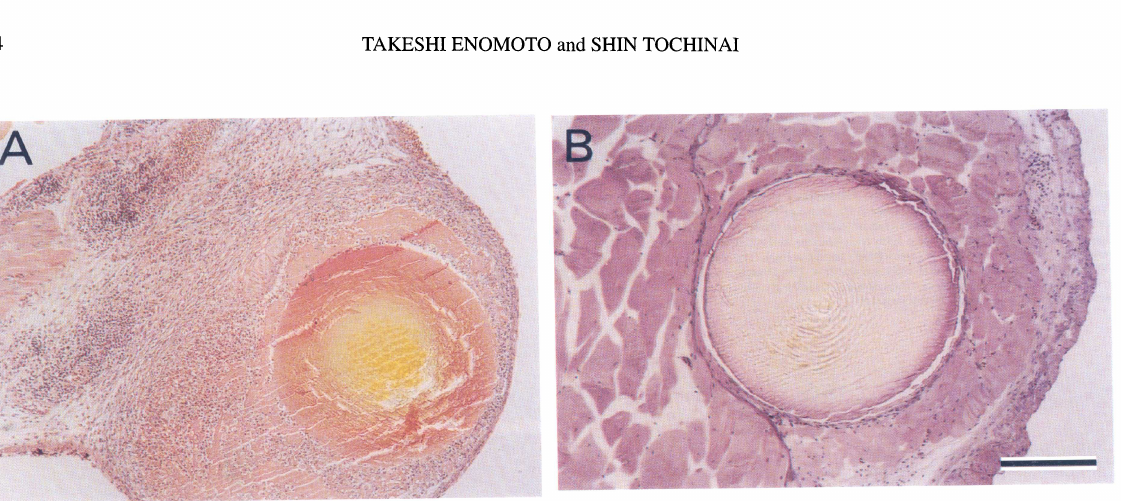
FIGURE Inflammatory tissues formed around the grafted lens 20 days after grafting. Intense inflammation with lymphocytes and phago- cytes occurred only around the lenses that were grafted in frogs enucleated at stage 43 (A) but not in frogs enucleated at the same stage and thymectomized soon after at stages 45 to 47 (B). (Bar, 200 micrometer). (see colour plate at the back of this